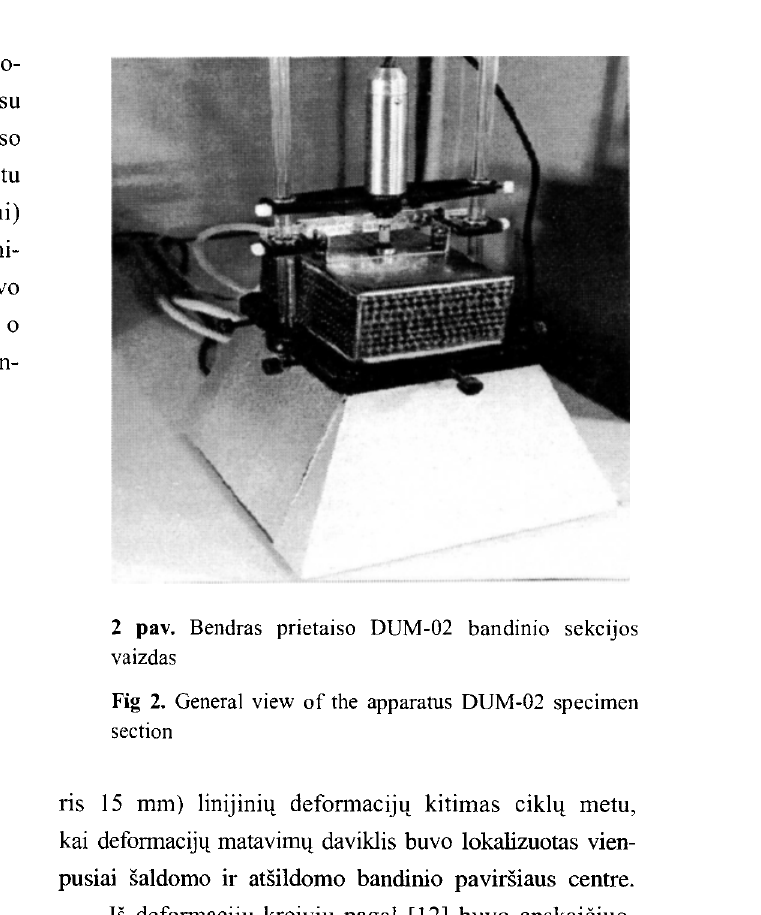
Fig 1. General view of ADOZO Po kiekvieno saldymo visi bandiniai buvo atSi1do mi specia1iose atSildymo kamerose virs vandens, palai kant santykin(;( dregm(;( (95 ± 2)% ir oro temperatiir<t plius ( 18 ± 2) °C, sudejus i jas konteineri ir kasetes su identiskais bandiniais. Laikyta (8 ± 0,5) h. To pakako bandiniams atSildyti.